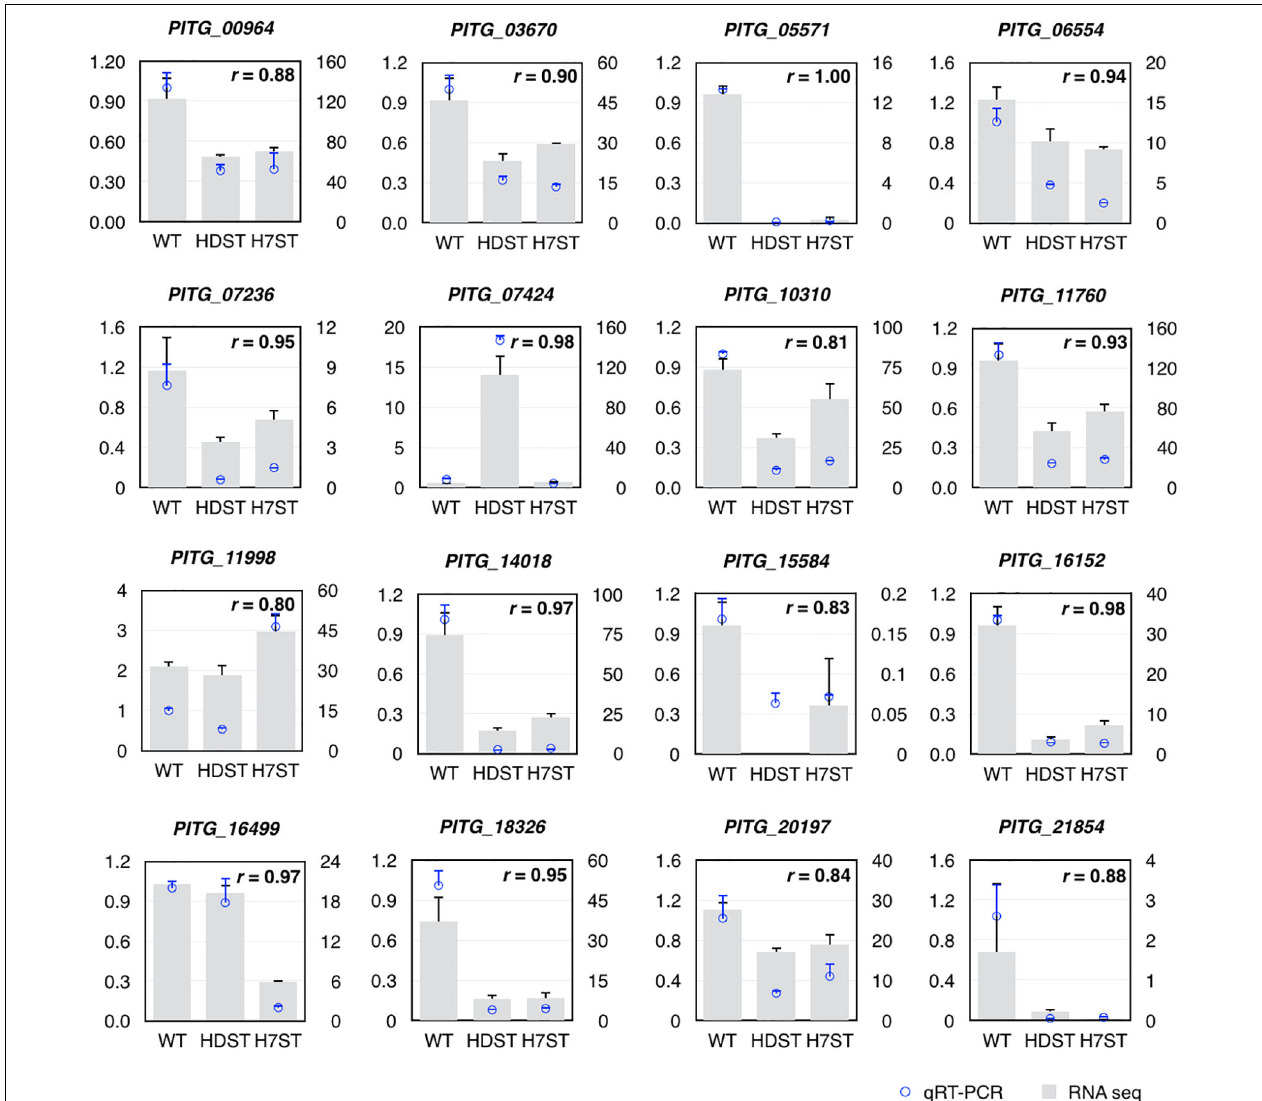
FIGURE 5 | Validation of differentially expressed genes by qRT-PCR. The left y-axis indicates the gene expression fold-changes based on the qRT-PCR data, whereas the right y-axis indicates the FPKM values based on the RNA-seq data, which represent the relative expression of the same gene in the HDST, H7ST, and WT strains. The r value represents the Pearson correlation coefficient of two data